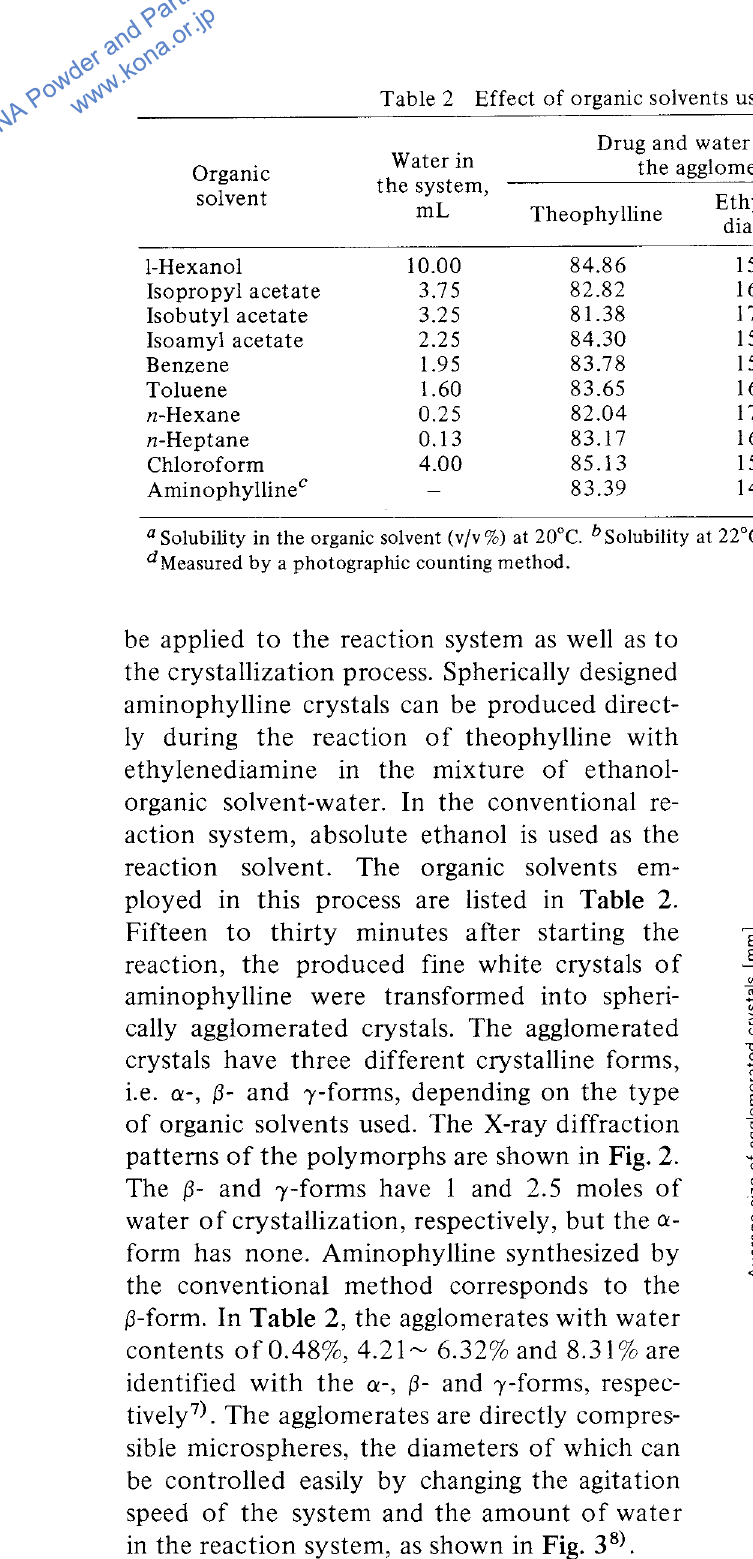
Agitation speed [rpm] Effects of agitation speed and amount of water in the system on average size (50%) of agglom erated crystals The size range between 16 and 84% is described by deviation bars. The medium for agglomera tion is methanol (o, •) or ethanol (0, +).The residence time is one hour after removal of the agglomerates adhering to the